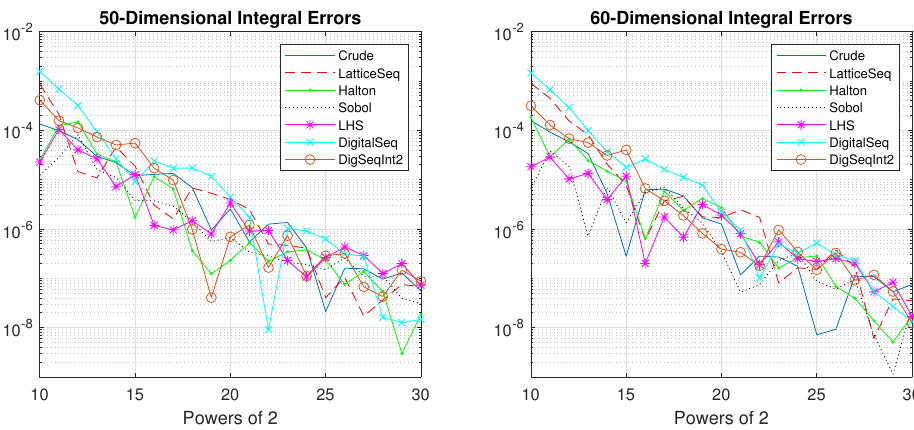
Figure 4. The 50- ( left ) and 60-dimensional ( right ) integral absolute